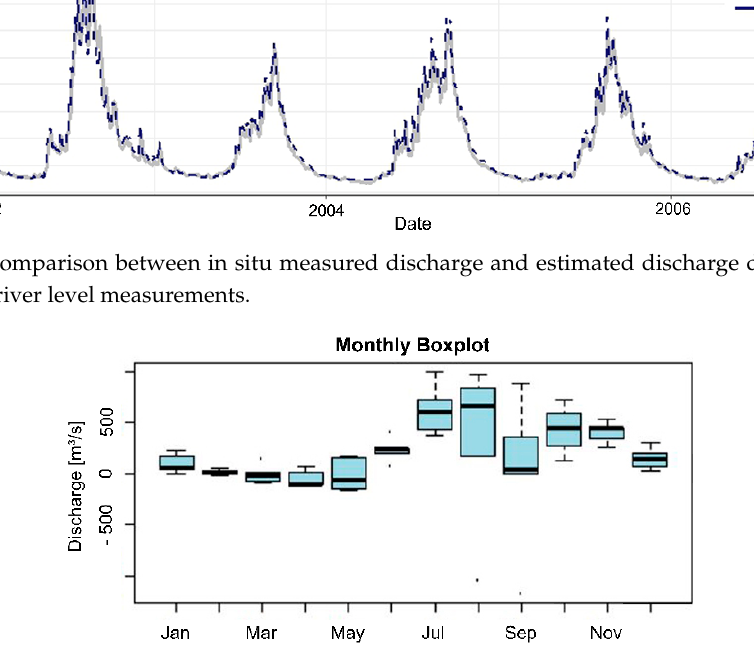
Figure 7. Boxplots of the monthly cumulated discharge difference between correlated and in situ measured discharge for the period from 2002 to 2006.